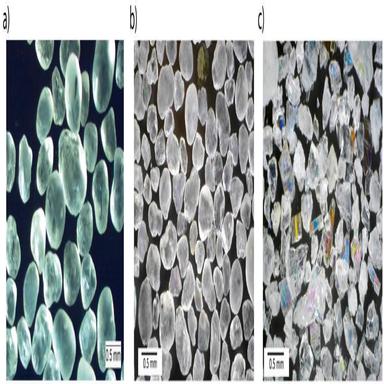
Silica-based sands used in this work: (a) AFS-50-70, (b) H-108 ASTM Test Sand, (c) crushed quarry sand composed mainly, but not solely, of high-purity quartz (polarized light illumination).